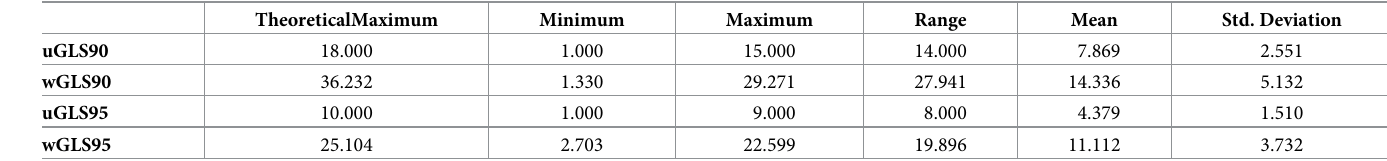
Table 4. Descriptive statistics of unweighted (uGLS) and weighted genetic longevity scores (wGLS) for survival to ages 90 and 95. TheoreticalMaximum